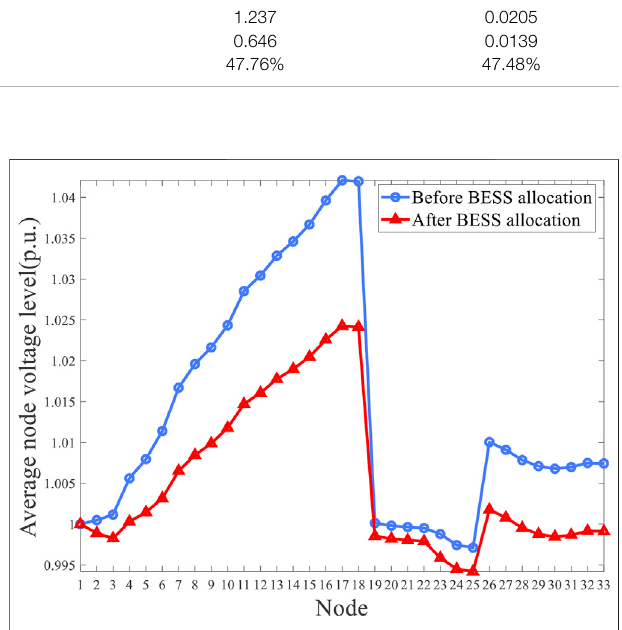
FIGURE 8 | Equivalent load curves under two